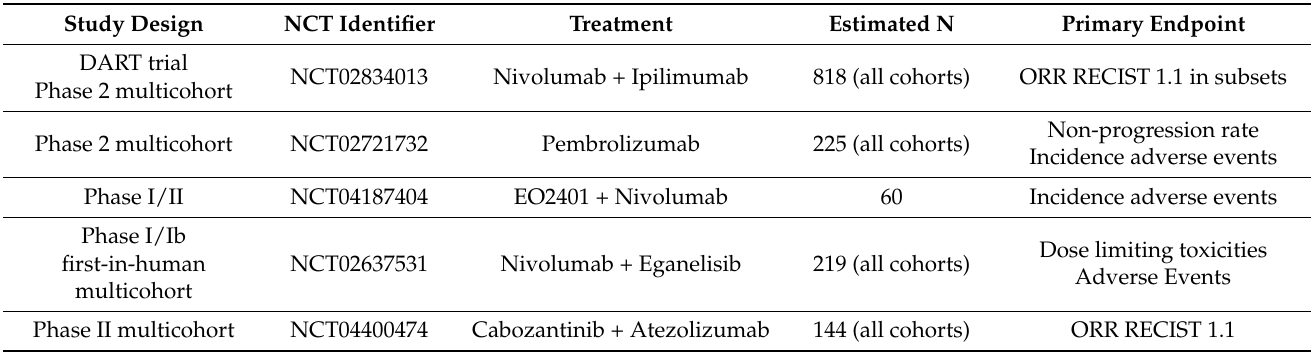
Table 3. Ongoing clinical trials with immunotherapy agents in advanced Adrenocortical carcinoma